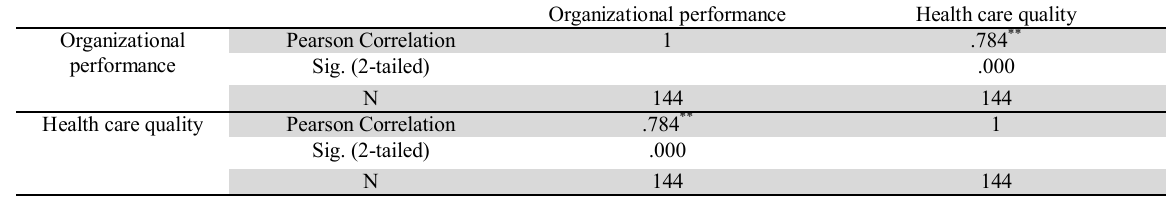
The results of relationship between health care quality and organizational performance Organizational